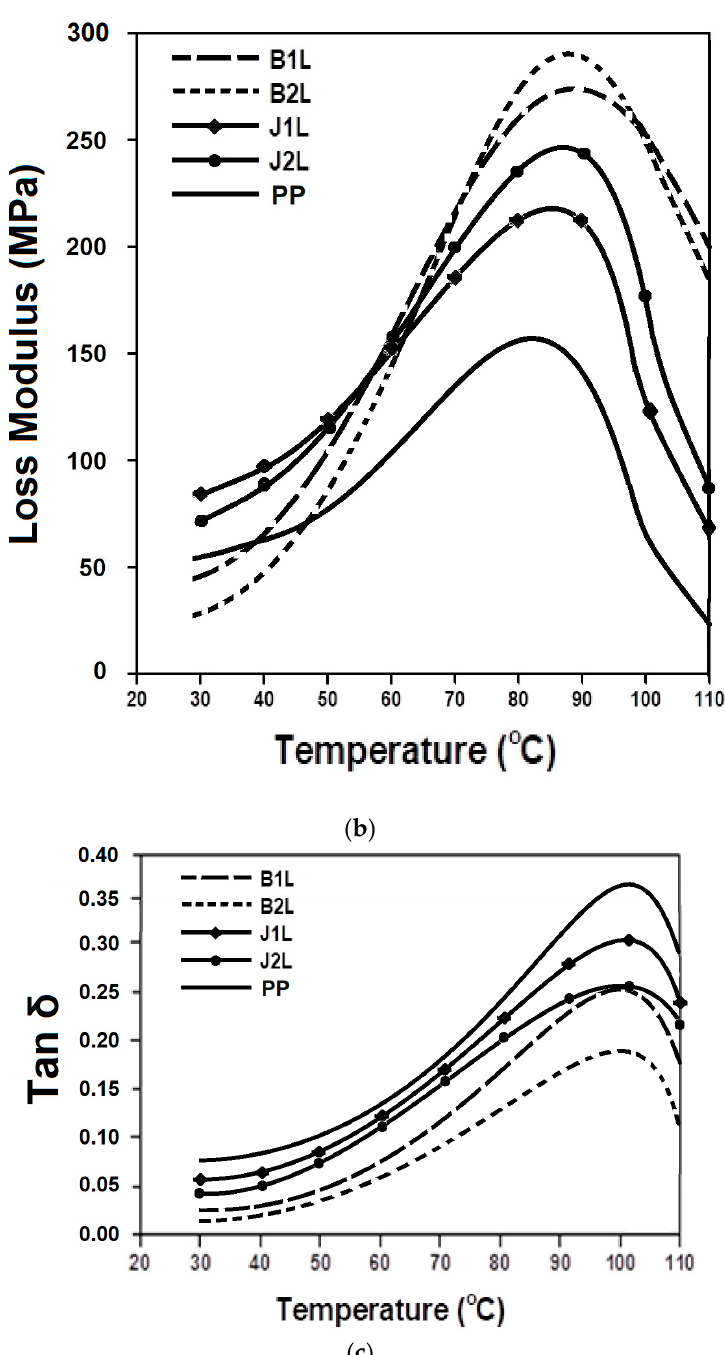
Figure 5. DMA analysis of the composites, ( a ) storage modulus, ( b ) loss modulus, and ( c ) tan δ of the samples. the